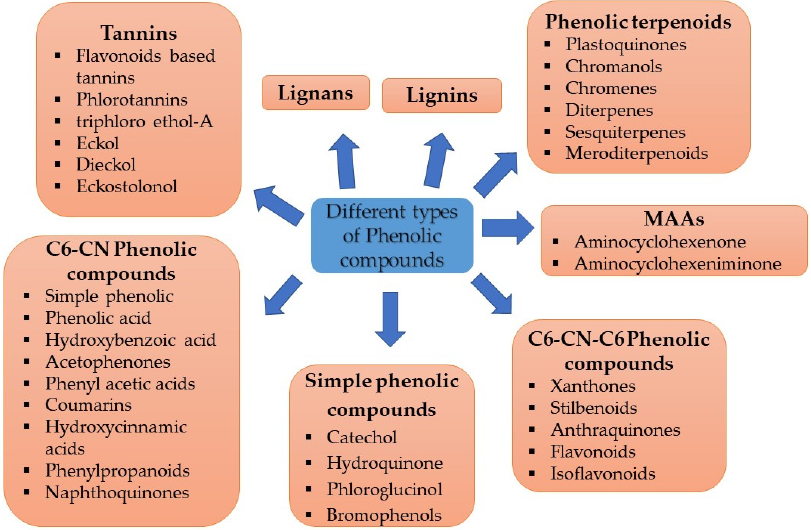
Figure 3. Classification of phenolic compounds listed according to their chemical structures. Source: Cotas et al. [36].